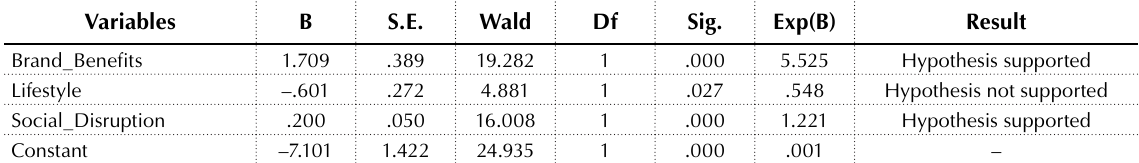
Table 8. Outcome of regression